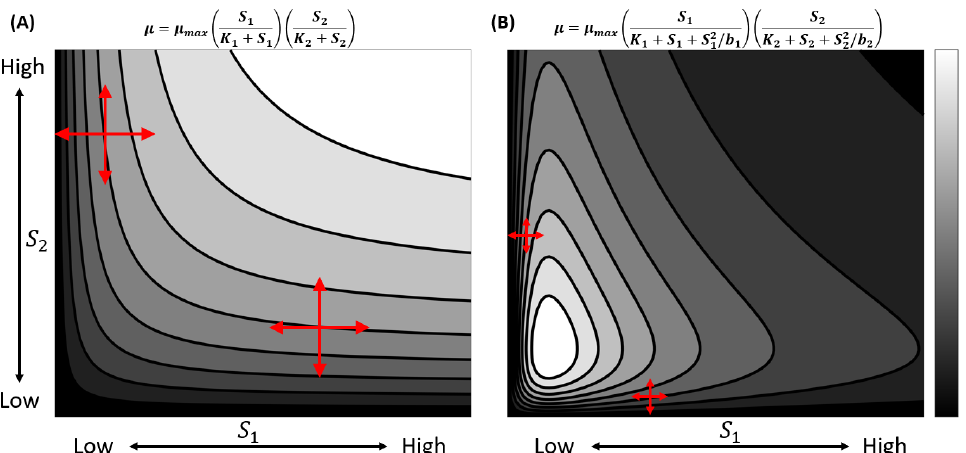
Figure 1. Two examples of colimitation with LLM as a special case. S 1 and S 2 are two resources that co-limit the growth of the organism. Light colors indicate higher growth and darker colors indicate lower growth. Instances of LLM are denoted by the red arrows. ( A ) No adverse effect and growth become infinite at infinite resources. ( B ) The inhibitory effect is incorporated at low and high resources. The maximal growth exists in case B, but not in A. These functional forms and additional ones have been studied previously